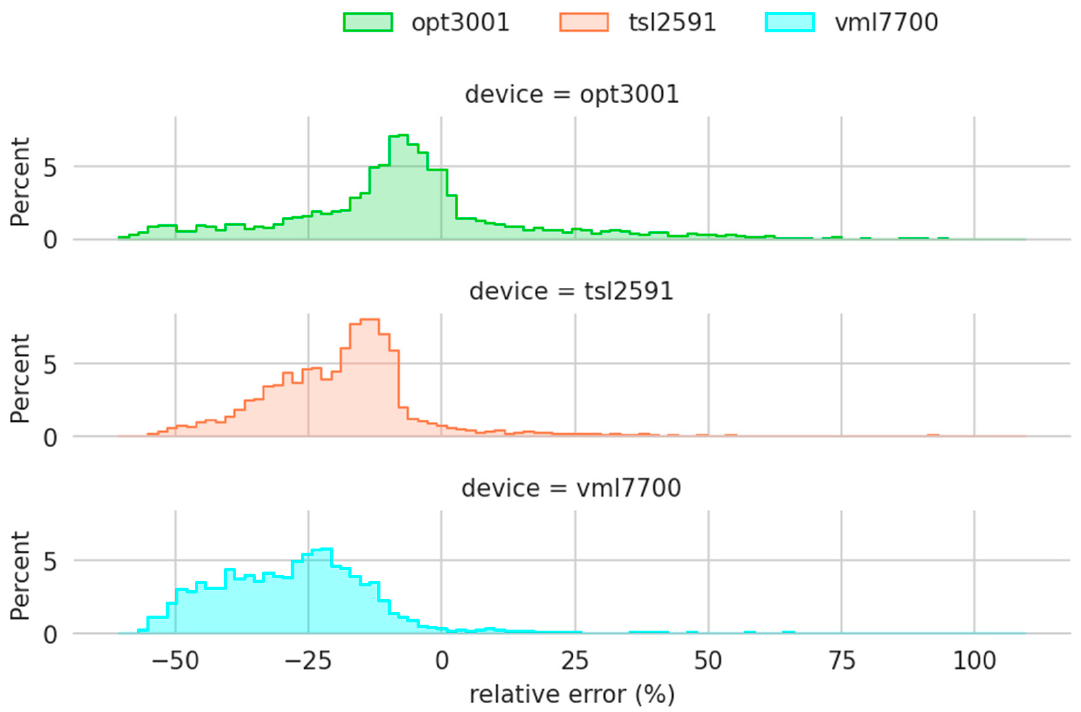
Figure 11. Histogram of the relative errors.